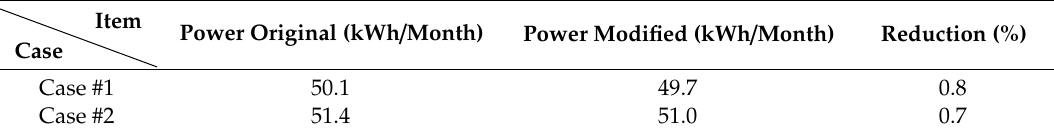
Table 2. Reduction in power of original and modified models.